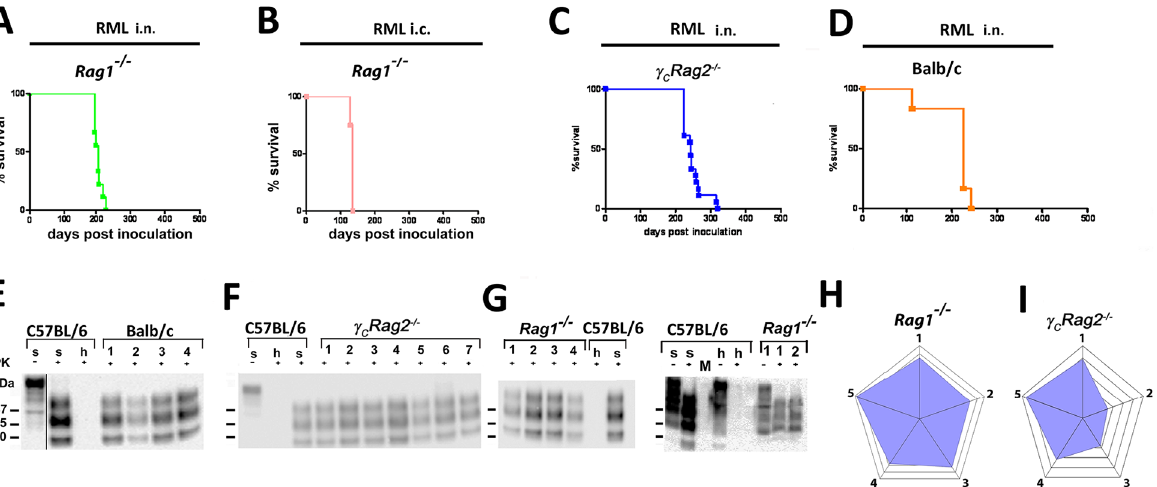
Fig 5. Prion transmission by intranasal instillation. (A) Rag1 − / − mice intranasally inoculated with RML6 0.1%, (B) Rag1 − / − mice i.c. inoculated with 3×10 5 LD 50 , (C) γ C Rag2 − / − mice intranasally inoculated with 4×10 5 LD 50 or (D) Balb/c mice intranasally inoculated with 4×10 5 LD 50 scrapie prions are shown. Survival curves (A – D) and respective Western blots (E – G) are indicative of efficient prion neuroinvasion. (E) Black line indicates crop marks; uncropped blots are shown in S1 File. Brain homogenates were analyzed with (+) and without ( − ) previous proteinase K (PK) treatment as indicated. Brain homogenates derived from a terminally scrapie-sick and a healthy C57BL/6 mouse served as positive and negative controls (s: sick; h: healthy), respectively. Molecular weights (kDa) are indicated on the left side of the blots. (H and I) Histopathological lesion severity score described as radar blot (astrogliosis, spongiform change and PrP Sc deposition) in 5 brain regions of both mouse lines exposed to prion aerosols. Numbers correspond to the following brain regions: (1) hippocampus, (2) cerebellum, (3) olfactory bulb, (4) frontal white matter, (5) temporal white matter.